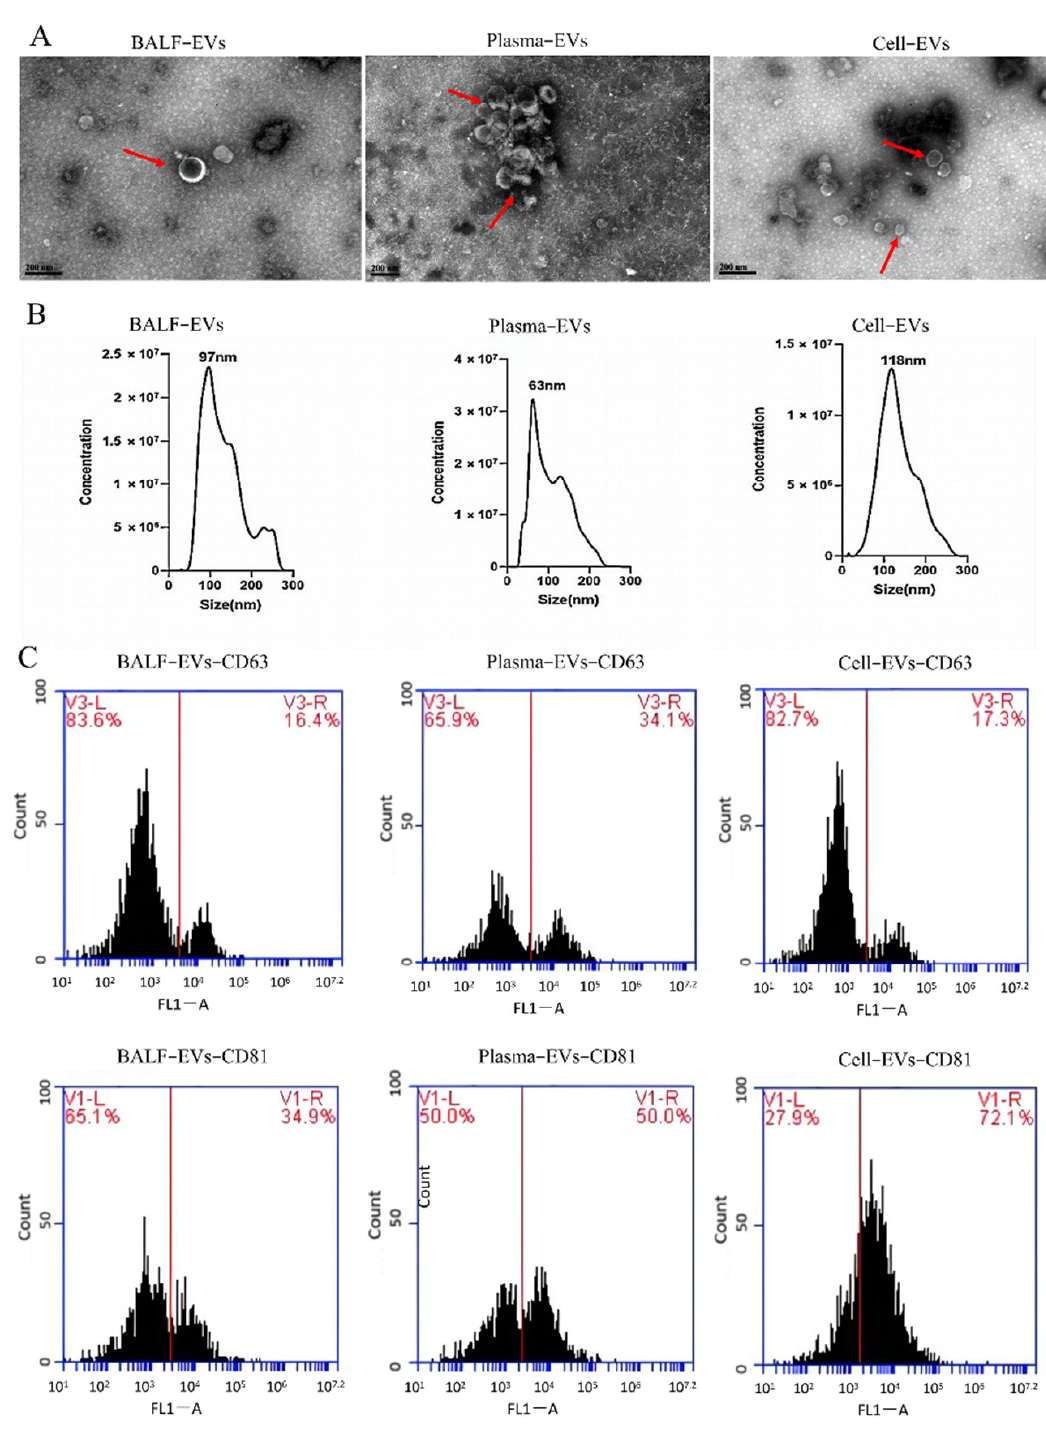
Figure 1. Characterization of extracellular vesicles (EVs) derived from different samples. ( A ) Trans- mission electron microscopy (TEM) images of EVs derived from bronchoalveolar lavage fluid (BALF−EVs), plasma (plasma−EVs), and cell culture supernatant (cell−EVs). Scale bars, 200 nm. ( B ) Different samples’ EVs particles were investigated by nanoparticle tracking analysis (NTA). ( C ) Markers for EVs (CD63 and CD81) were detected by flow cytometry analysis.